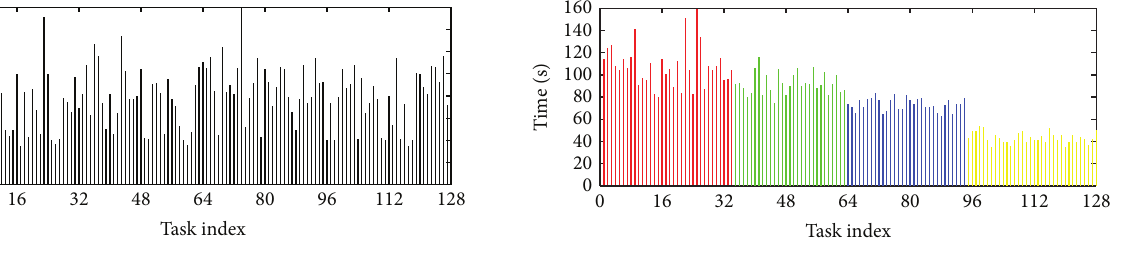
Figure 2: Execution time of tasks. There are 128 map tasks in total and each execution time of task was plotted.